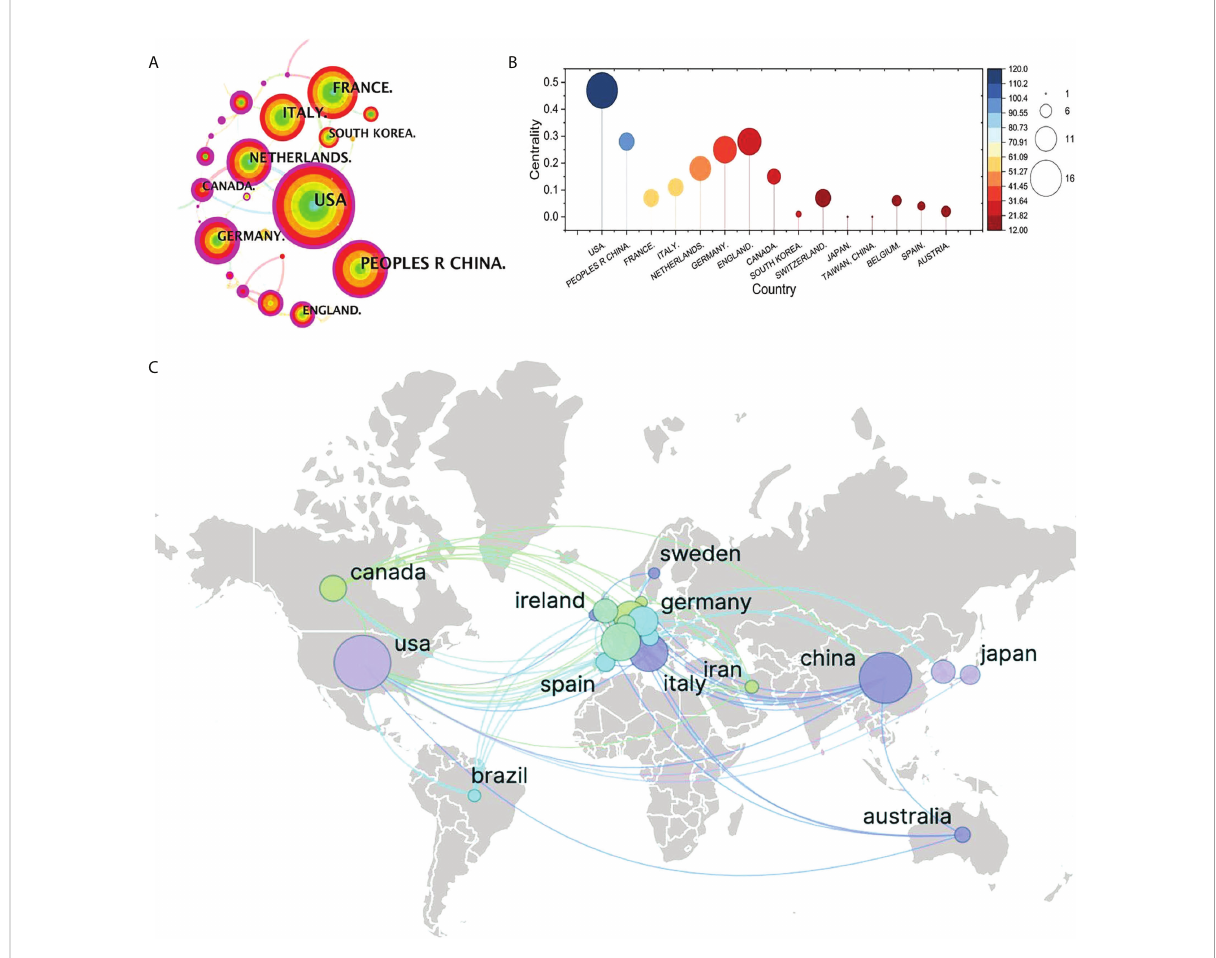
FIGURE 4 Visualization map of cooperation between countries. (A) Collaboration visualization map of countries of bibliometric app (CiteSpace), N = 641, E = 560 ( N represents the number of visualization map nodes. E represents the number of connections). The nodes in the visualization map represent countries/regions/institutions, and the connection line represents the strength of the relationship between the two nodes. The larger the circle of the node, the greater the volume of published documents. The thicker the connection, the closer the cooperative relationship. (B) Top 10 most productive countries involved in 18 F-FDG PET/CT radiomics research. (C) Collaborative research relationships between countries based on VOSvieser and Scimago